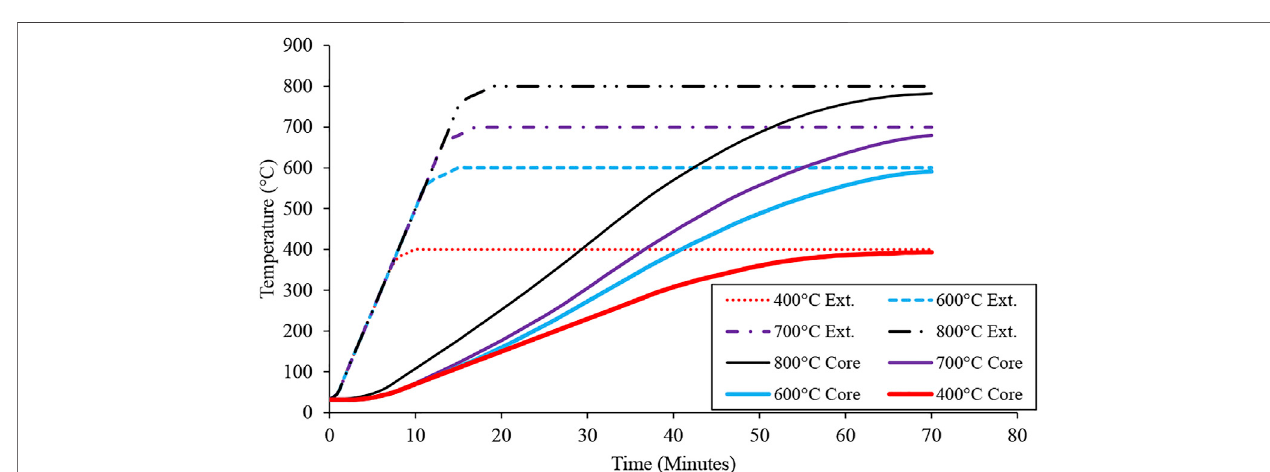
FIGURE 2 | Average adjusted furnace time-temperature curves for heating